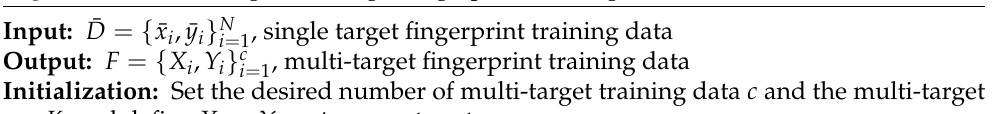
Algorithm 1 Rendering multi-target fingerprint training dataset